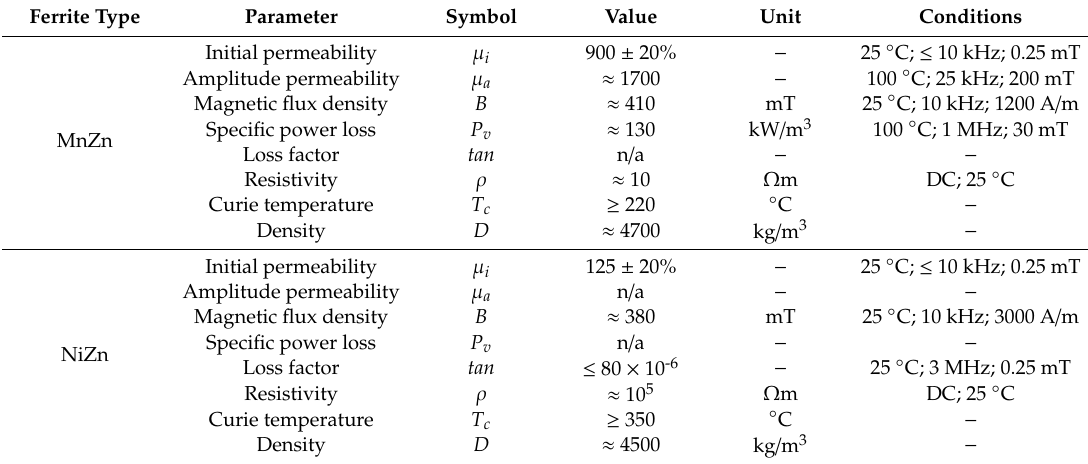
Table 4. Specifications of soft ferrite materials used in the